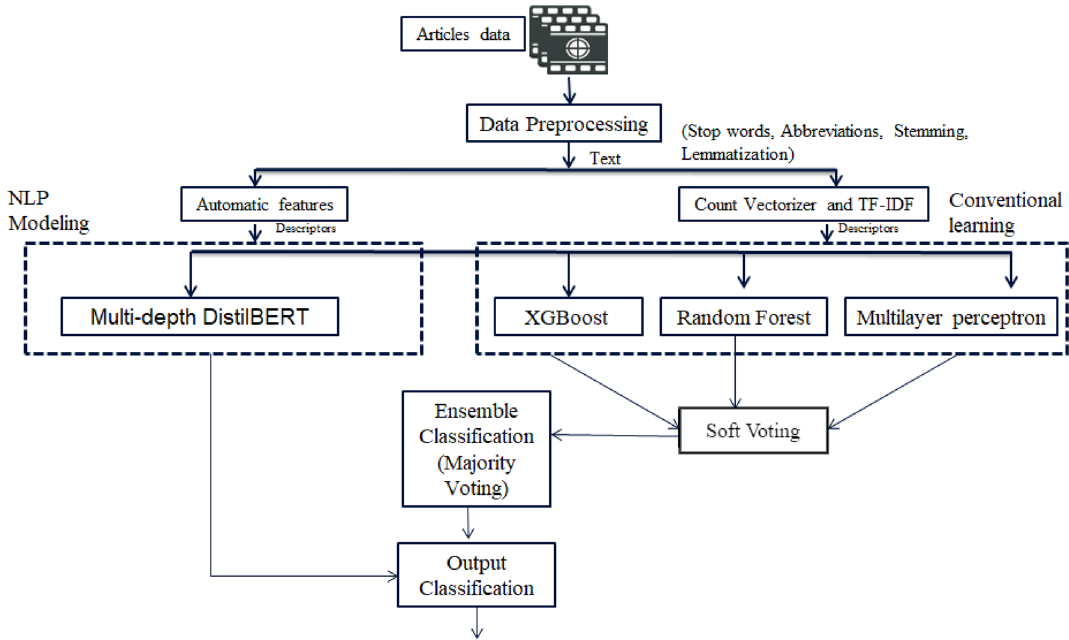
Figure 6. Graphical Representation of Proposed Approach for Authorship identification and